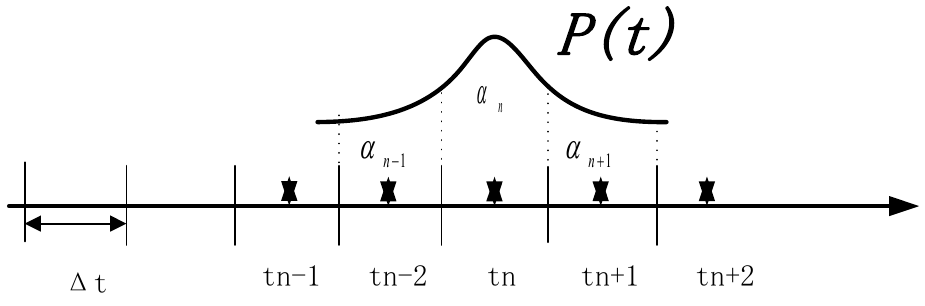
Figure 4. The probability density function of uncertainty.